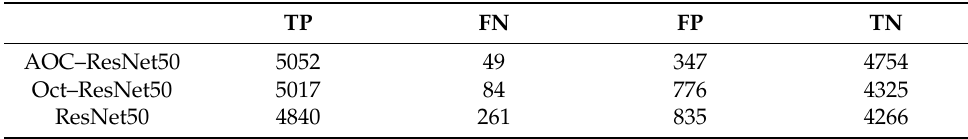
Table 5. Converter fault detection